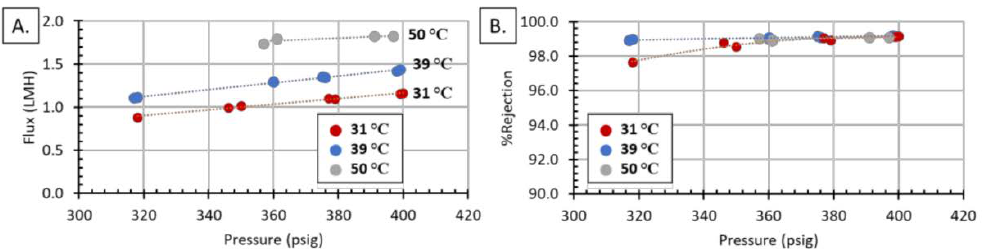
Figure 9. Module 2 characterization using 14,400 PPM FGD wastewater. Effects of temperature and pressure on: ( A ) water flux and ( B )%rejection.